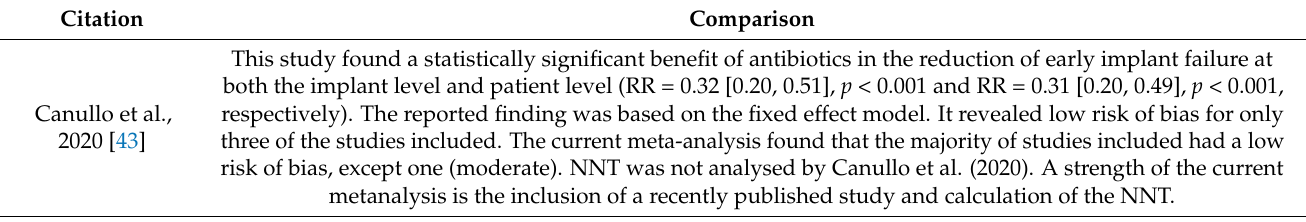
Table 4. Comparison of findings with previous systematic